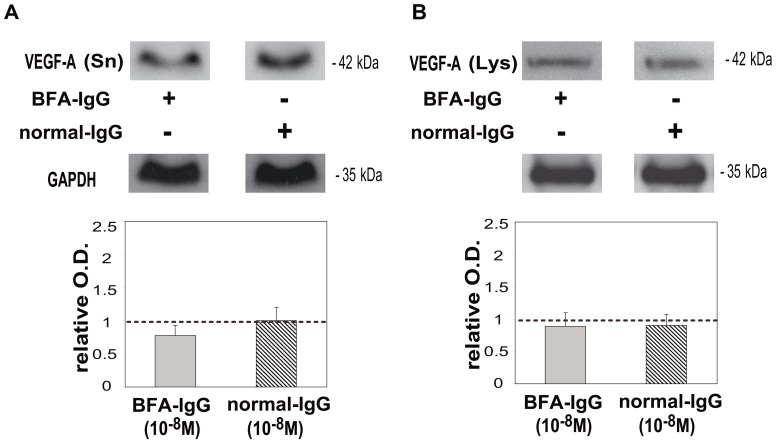
Effect of BFA-IgG and normal IgG on VEGF-A expression in MCF-7 cells.Tumor cells were treated with 10−8 M benign fibroadenoma (BFA) or normal-IgG during 1 h and Western blot assays were performed in MCF-7 cell A) supernatants (Sn) and B) lysates (Lys). Densitometric analysis of the bands is shown. Values were relativized to the expression of glyceraldehyde-3-phosphate dehydrogenase (GAPDH) and to VEGF-A in MCF-7 cells without treatment considered as 1, and is represented by a dotted line. Molecular weights are indicated on the right. Values are mean±S.E.M. of three experiments.